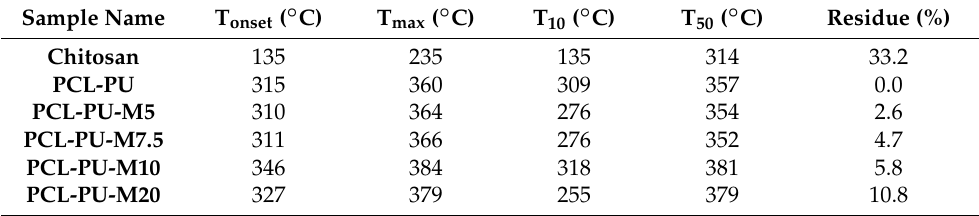
Table 1. Thermal transitions and percentage residue for PCL-PU and PCL-PU-Chitosan